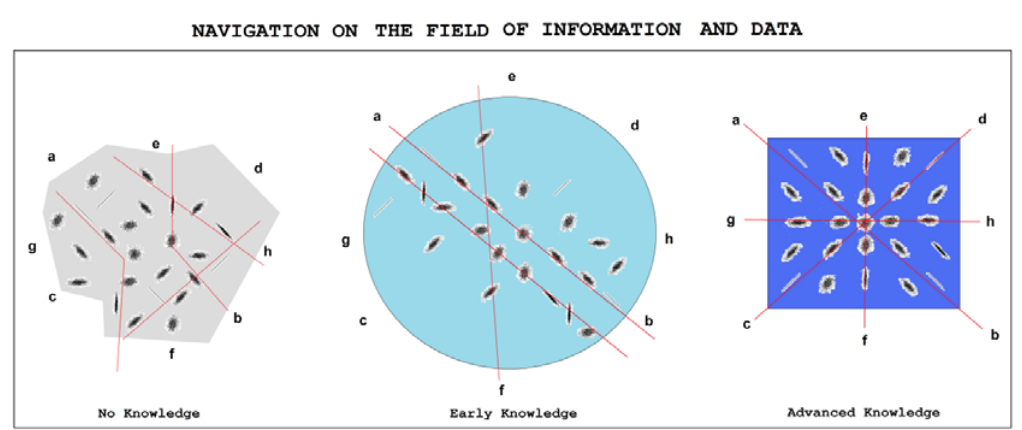
Figure 8. Navigation in the field of Information and Data. Data (dots) are sorted into information (elliptical forms). The information may or may not complete (connect) different fields of existing knowledge (a-h,